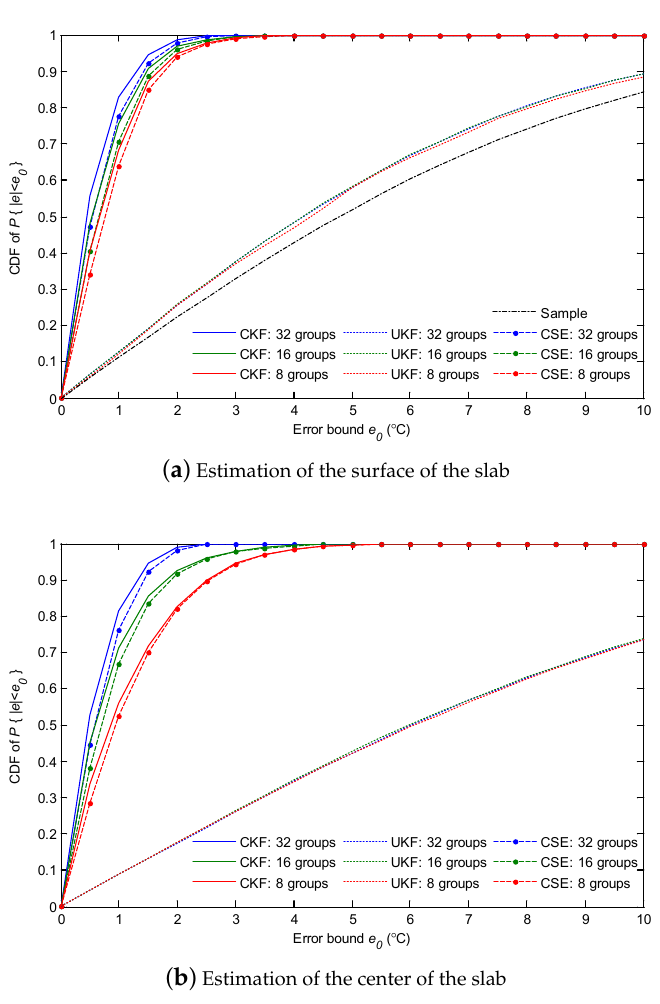
Figure 12. The CDF of the absolute error of temperature estimation with different network